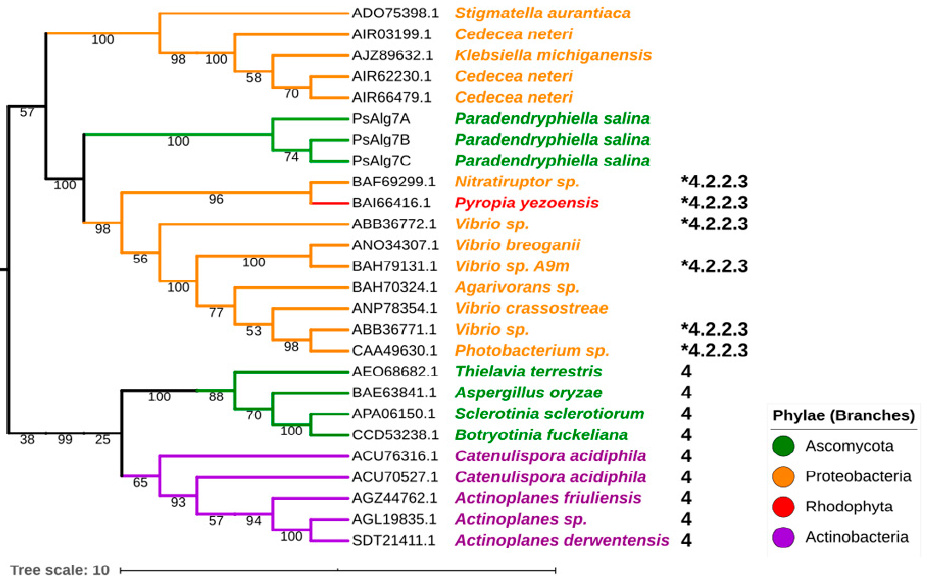
Figure 2. Maximum likelihood tree of selected PL7 family sequences from the CAZy database. The * indicate EC number of characterized members (4.2.2.3 = polyM-specific alginate lyase). The single numbers indicate subfamily classification from CAZy. The branch colors indicate phylae. Branch numbers indicate bootstrap values. The tree scale bar indicates substitution changes per site. This tree is a pruned and updated version of the tree presented in a previous study [22].